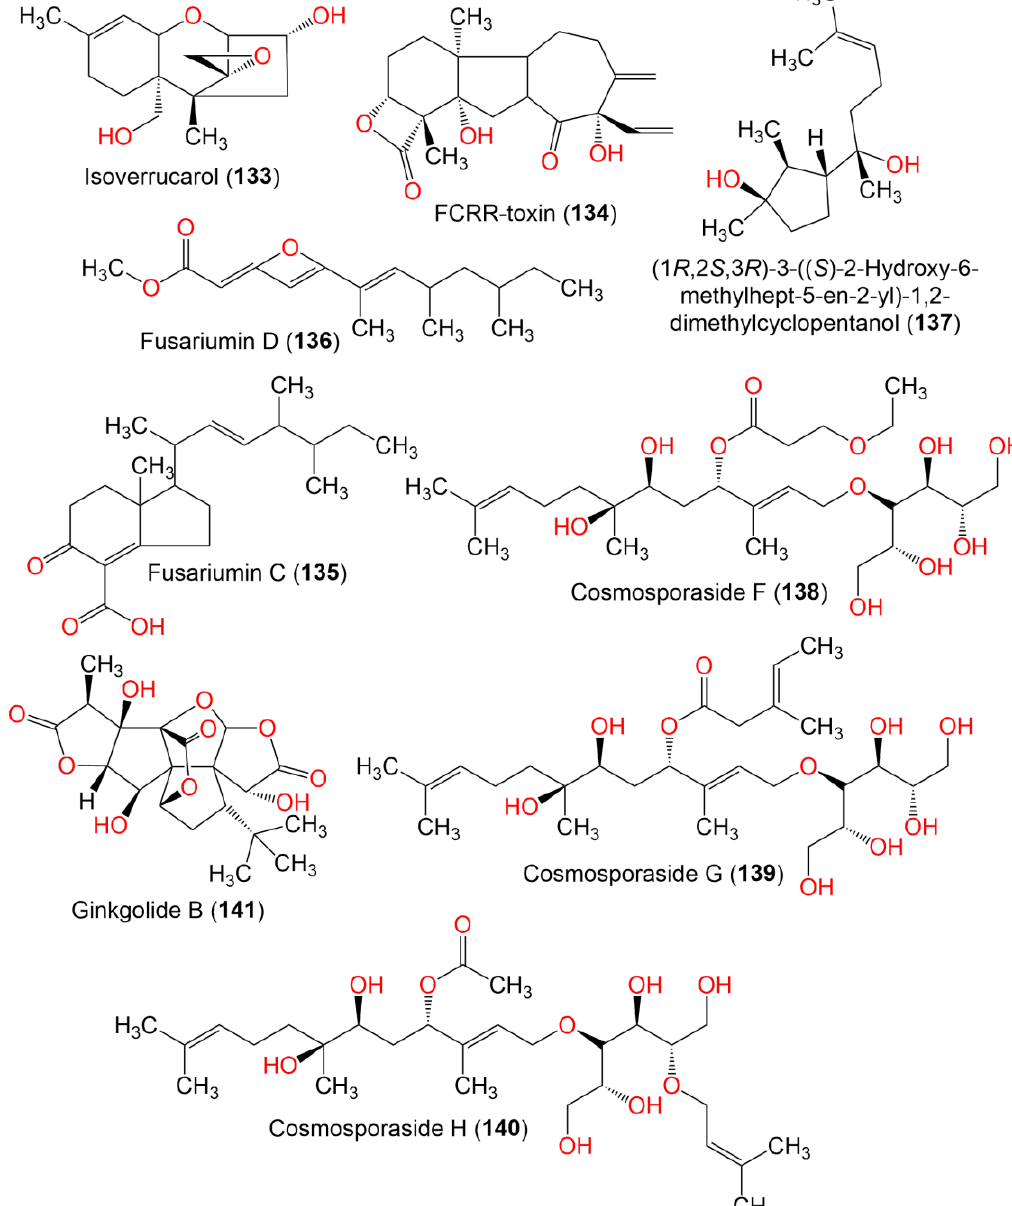
Figure 15. Structures of terpenoids ( 133 – 141 ) isolated from F. oxysporum .